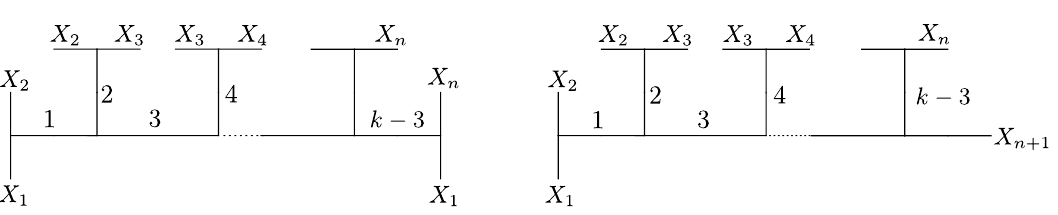
Figure 6 . The trivalent diagrams associated to the OPE density Q k . These diagrams correspond to one of the possible OPE channel decompositions of the k -point function for even ( left ) k = 2 n or odd ( right ) k = 2 n − 1 values of k